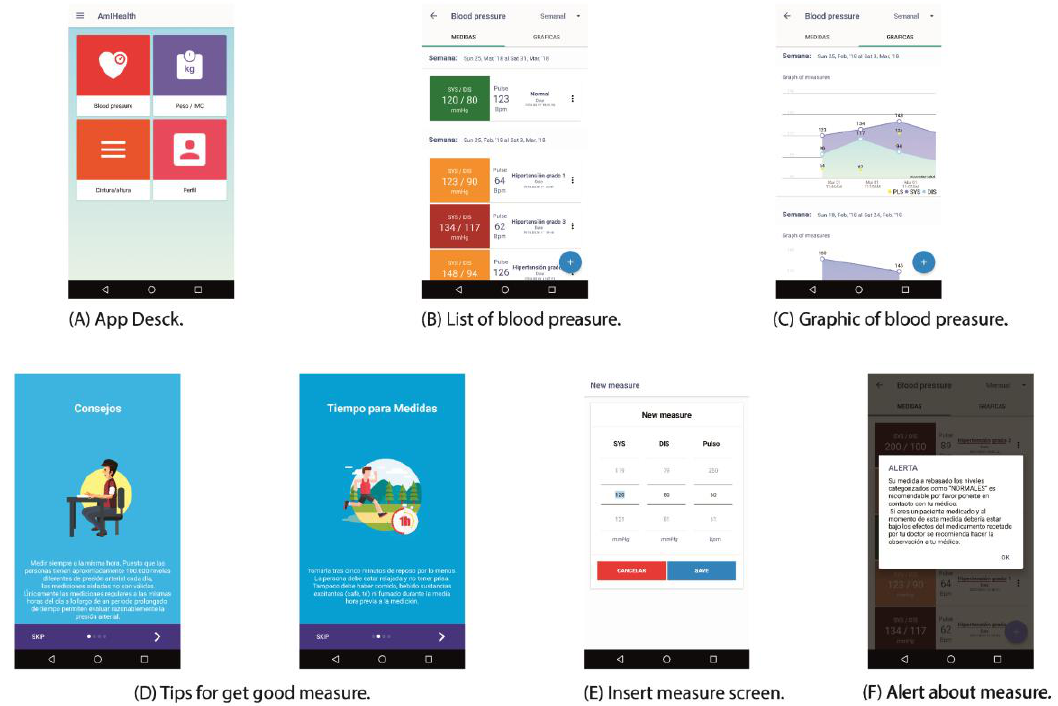
Figure 15. Blood pressure module through the android client.